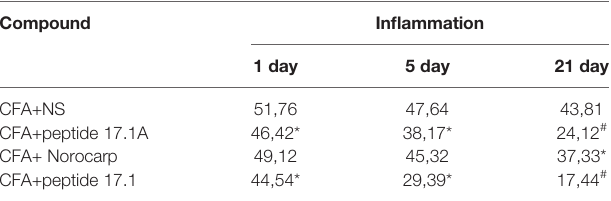
The values are presented as % of the mean. Signi fi cant difference (*P < 0.05; # P < 0.01) between treated (17.1, 17.1A, Norocarp) and non-treated groups (n = 10 in each group).